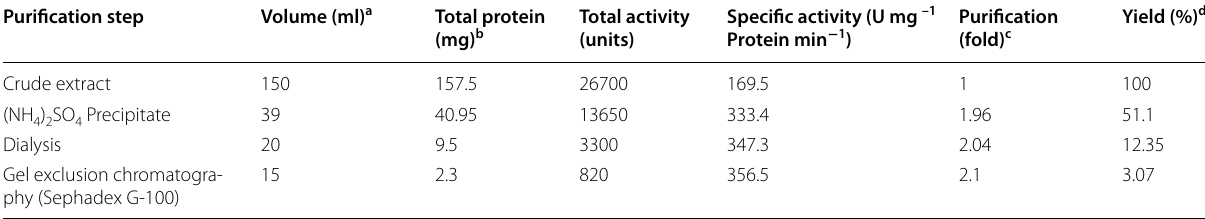
a , b values represent the mean of the values from three independent experiments, with a standard deviation of < Specific activity total activity/total protein = c Purification fold specific activity of particular purification step/specific activity of the crude enzyme = d Yield (%) (total activity of the particular purification step/total activity of the crude enzyme) =